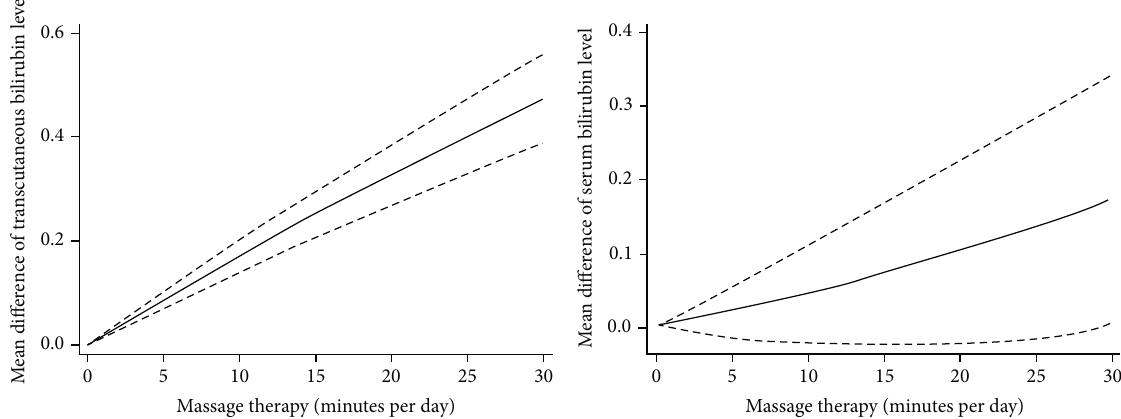
Figure 2: The dose-response relationship between massage therapy (per minute in day) and mean of serum/transcutaneous bilirubin level (mg/dl); the solid line represents the fi tted linear trend, and the dashed line represents the 95% con fi dence